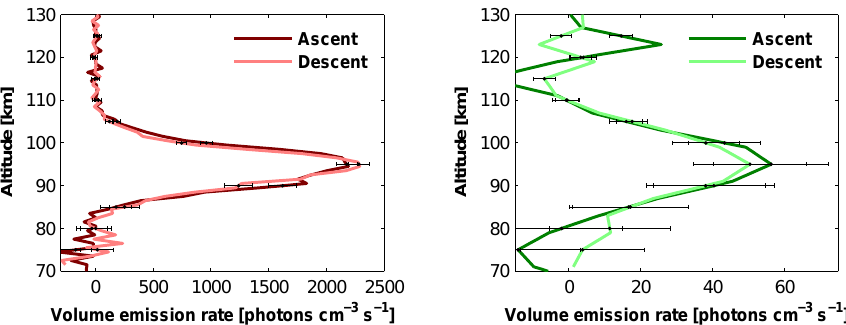
Fig. 3. The volume emission rates of the O 2 Atmospheric band (left panel, 1km resolution) and the NO 2 continuum (right panel, 4km resolution) nightglow emissions as determined from the photometric measurements on ECOMA7 (with the error bars showing the error of the